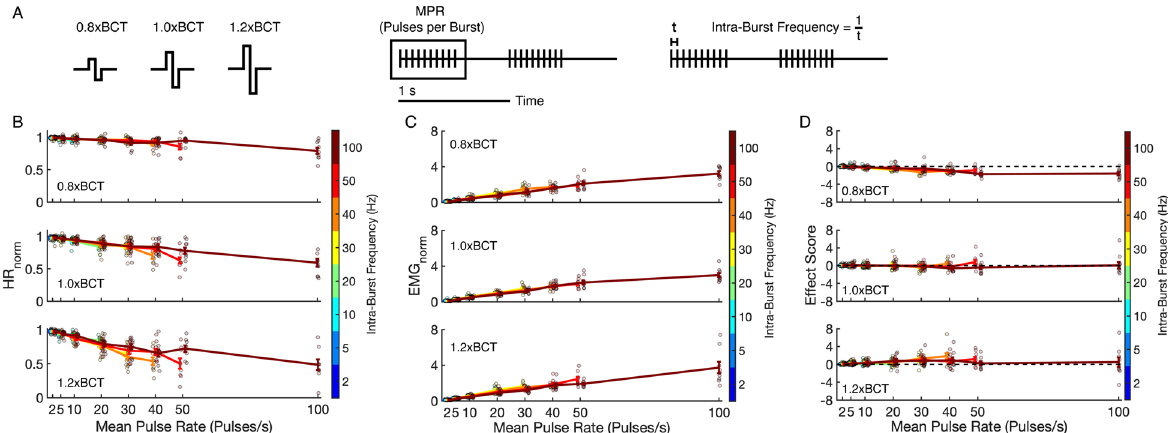
Fig. 3 In vivo responses to burst patterns of VNS at amplitudes of 0.8xBCT (top row), 1.0xBCT (middle row), and 1.2xBCT (bottom row) across mean pulse rates (x-axis) and intra-burst frequencies (color). A Illustration of stimulation parameters, including amplitude (0.8xBCT, 1.0xBCT, and 1.2xBCT), mean pulse rate (MPR), and intra-burst frequency. B Heart rate normalized to pre-stimulation baseline (HR norm ). C EMG normalized to response from stimulation at 1.0xBCT, 20 pulses/s, 20 Hz (EMG norm ). D Effect score combining both heart rate and EMG responses normalized to the response from stimulation at 1.0xBCT, 20 pulses/s, 20 Hz. Data are presented as mean standard error with individual data points as points, n 8-10/parameter ± =